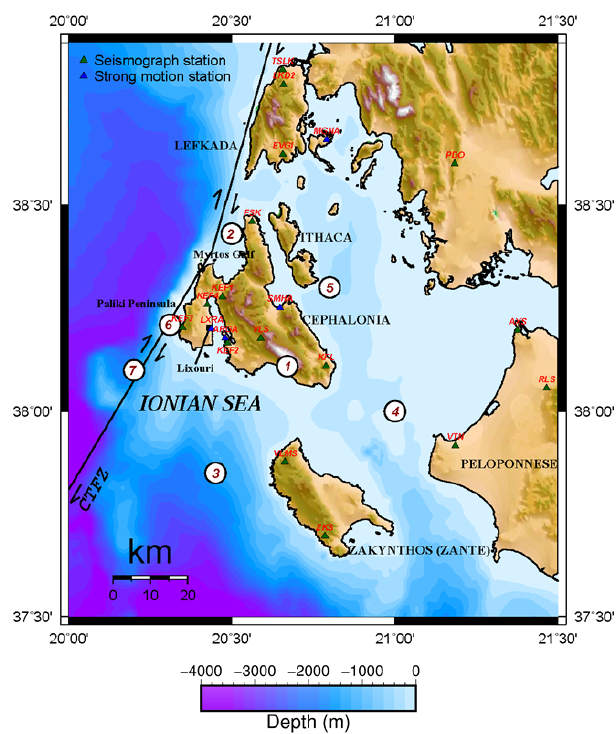
Figure 1. Location map of the study region. The Cephalonia Trans- form Fault zone (CTFZ) is also indicated on the map. The seis- mographic stations of the Hellenic Unified Seismological Network (HUSN) are depicted with green-colored triangles and the strong motion stations with blue ones. Significant earthquakes after 1900 (Papazachos et al., 2010) are shown as white circles: (1) 24 Ja- nuary 1912, M = 6 . 8; (2) 9 August 1953, M = 6 . 4; (3) 11 August 1953, M = 6 . 8; (4) 12 August 1953, M = 6 . 3; (5) 12 August 1953, M = 7 . 2; (6) 17 September 1972, M = 6 . 3; (7) 17 January 1983, M = 7 .